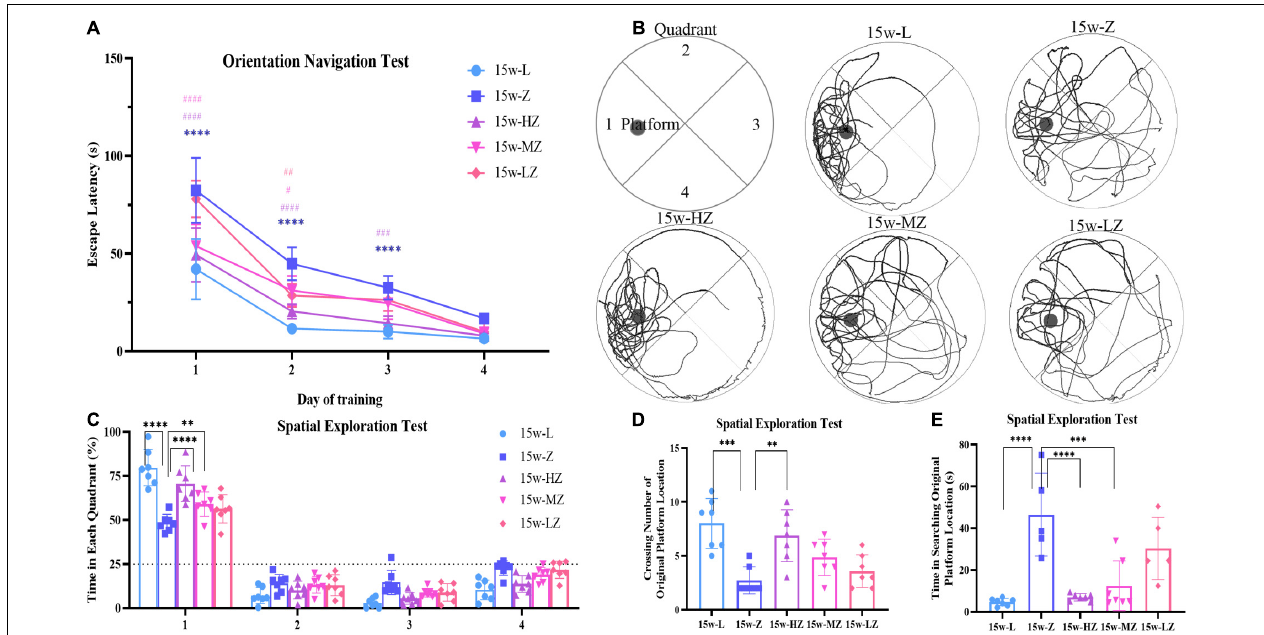
FIGURE 3 | Morris water maze test was used to evaluate the effect of ZBPYR on learning and memory performance of rats. (A) The escape latency during a 4-day training course in the orientation navigation test. (B–E) Representative swimming path (B) , time spent in each quadrant (%) (C) , crossing number of the original platform location (D) , and time in searching original platform location (E) in the spatial exploration test. The small circle in Figure 2B represents the original platform location, but the escape platform was removed in the spatial exploration test. Data are shown as mean ± SD. n = 7 per group. **** p < 0.0001, compared with 15w-L group; # p < 0.05, ## p < 0.01, ### p < 0.001, #### p < 0.0001, compared with 15w-Z group in Figure 2A . ** p < 0.01, *** p < 0.001, **** p < 0.0001 in Figures 2C–E